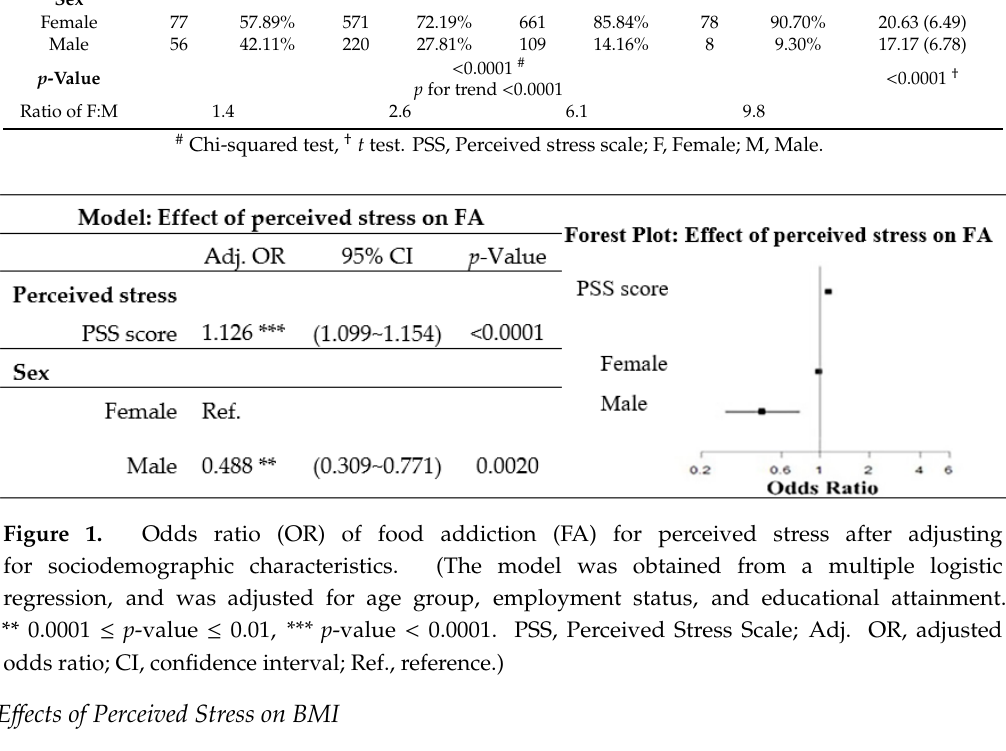
Table 2. Perceived stress scores by sex.